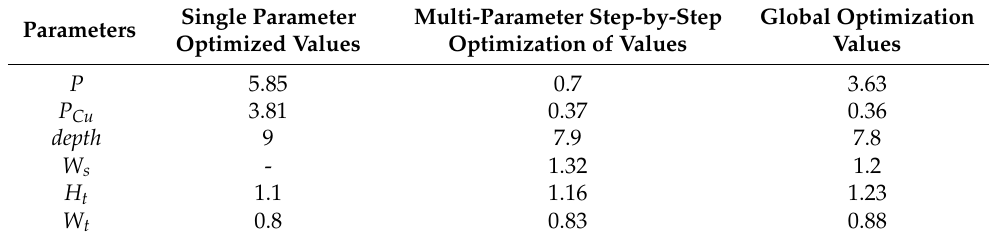
Table 8. The result of global optimization.